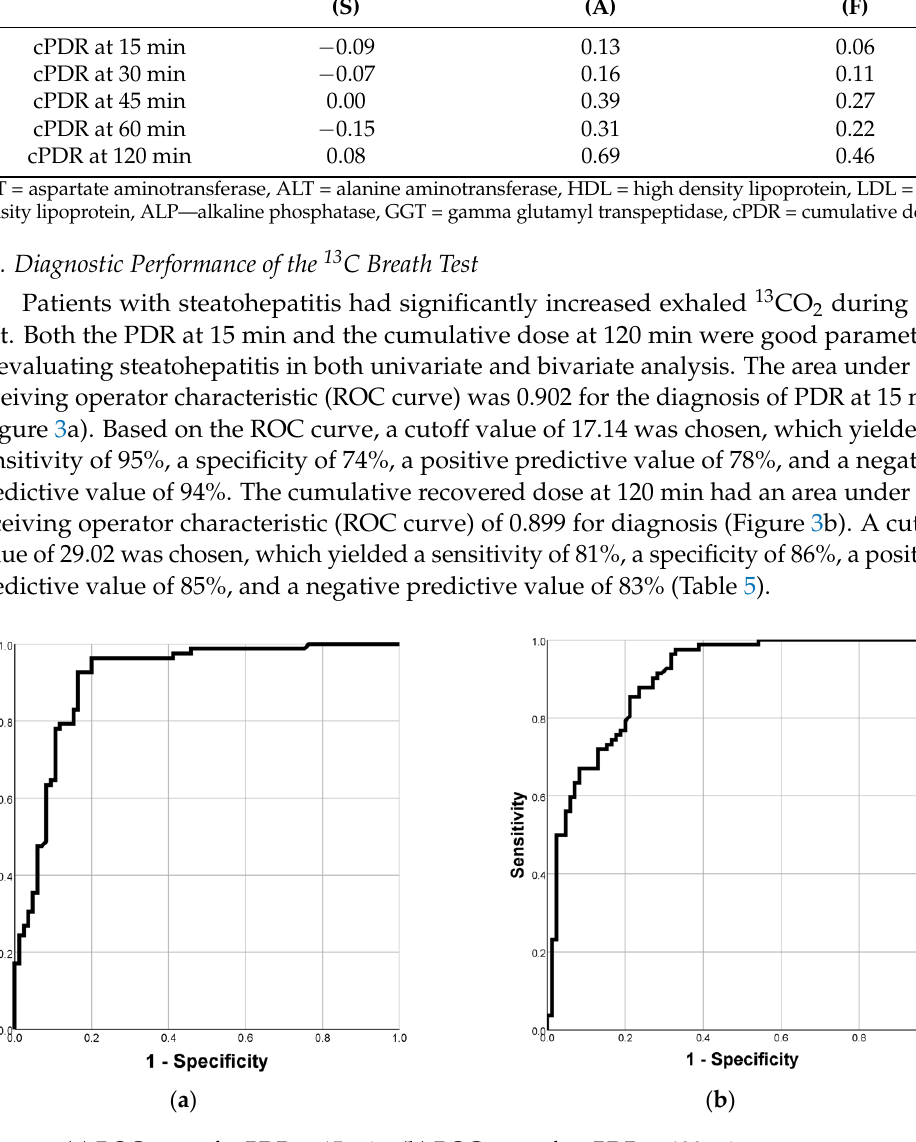
Figure 3. ( a ) ROC curve for PDR at 15 min; ( b ) ROC curve for cPDR at 120 min. Table 5. Diagnostic accuracy for Octanoate breath